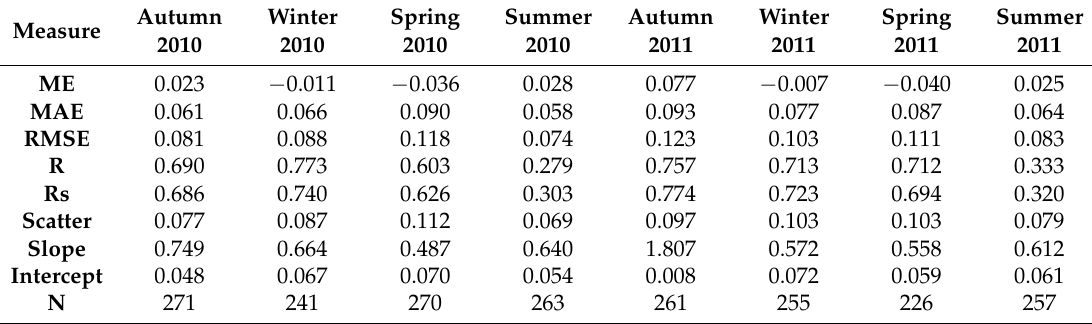
Table 5. Comparison between Satellite (ASCAT 25Km) and observed SSM at validation sites in USA, including all of the datasets for 2010 and 2011.